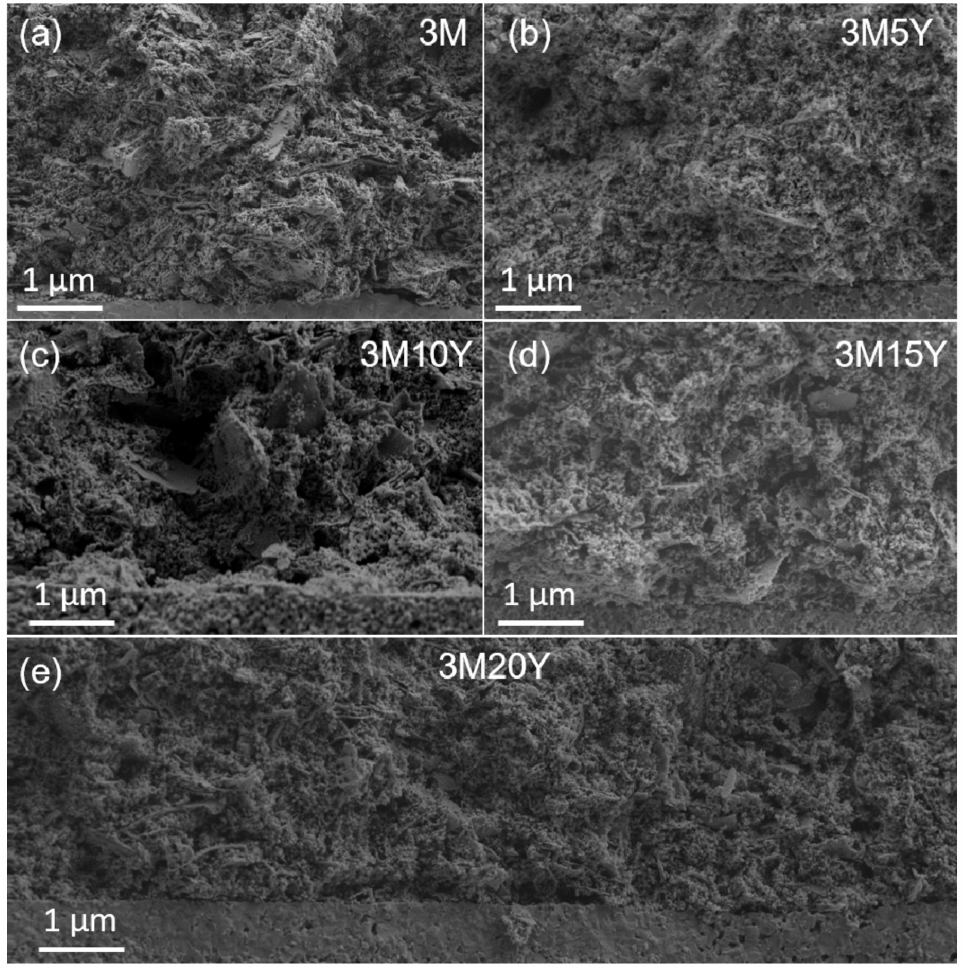
Figure 10. SEM images of tested symmetric cells produced at 900 ◦ C ( a , b ) and 1000 ◦ C ( c – e ). The cells were tested by EIS from 400 ◦ C to 600 ◦ C in 3% moist synthetic air. Table 2. Summary of the thickness and porosity of the cathodes before and after electrochemical characterization. The porosity is the average of more than 40 images and the standard deviation is given in parenthesis. Thickness of the Cathode ( µ m) Porosity (%) Code Before Testing After Testing Before Testing After